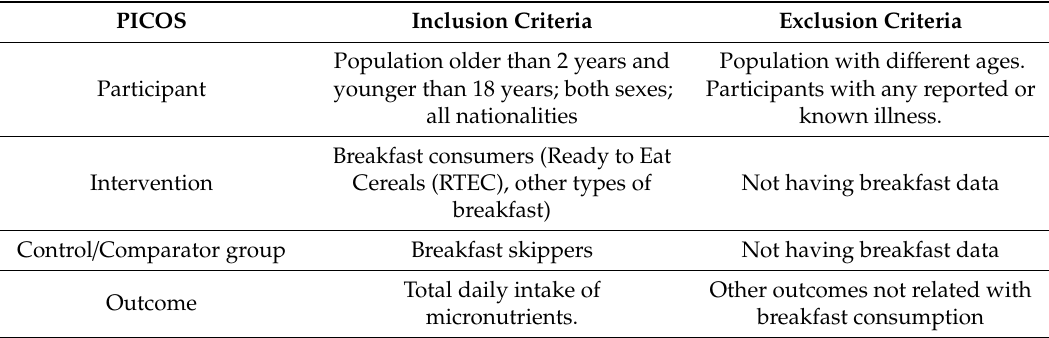
Table 1. Inclusion and exclusion criteria based on PICOS (Participants, Intervention, Control, Outcomes)